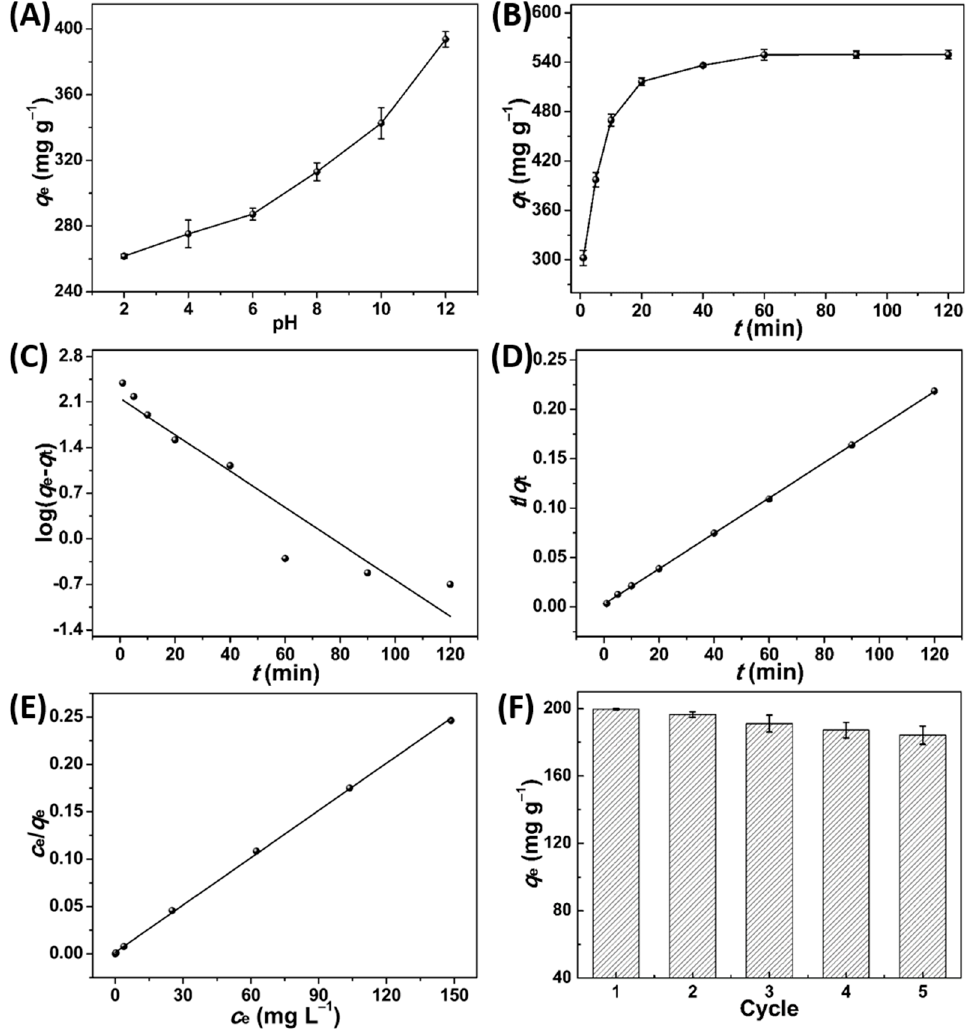
Figure 4. Effect of ( A ) pH ( c 0 : 200 g L − 1 , 2 h, 25 °C); ( B ) t ( c 0 : 200 g L − 1 , pH: 12, 25 °C); ( C ) pseudo-first order kinetic; ( D ) pseudo-second order kinetic; ( E ) Langmuir isotherm of MB adsorption on PPPC; and ( F ) the reusability of PPPC toward MB adsorption ( c 0 : 100 g L − 1 , pH: 12).